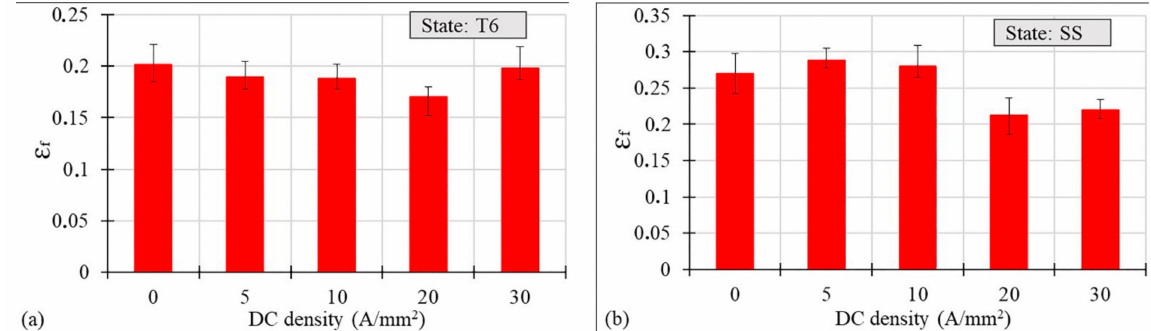
Figure 4. True strain at fracture vs. DC density for the AA7075-T6 ( a ) and SS ( b )